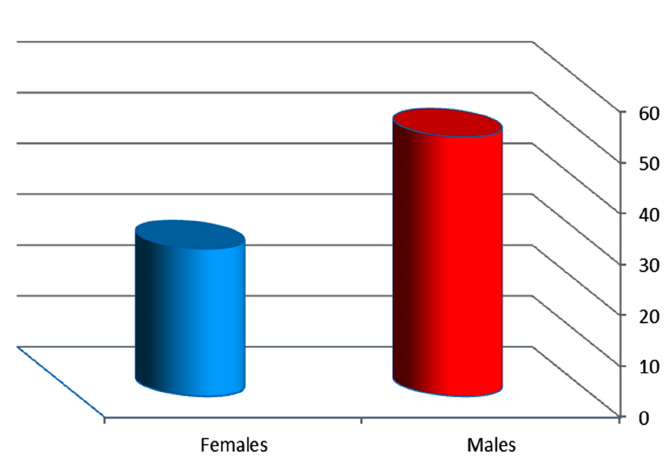
Fig. 3. Distribution of pneumonia infections based on